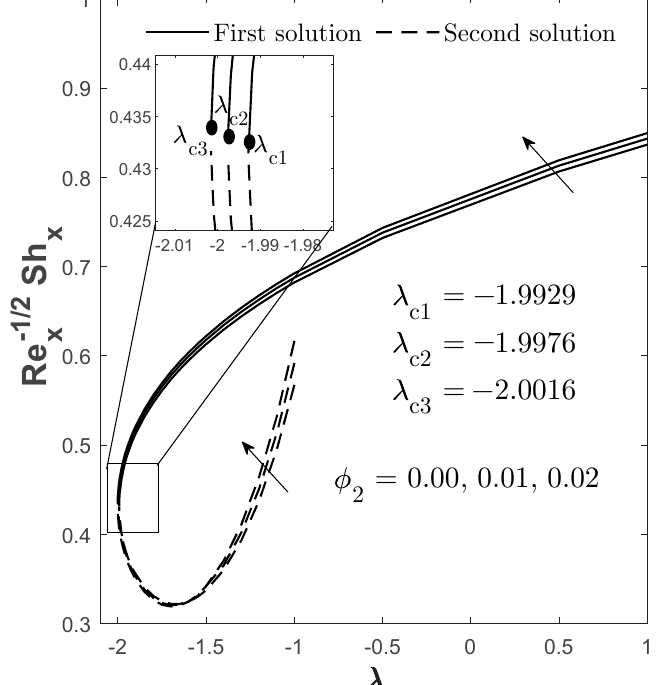
Sh − for varied Figure 4. 1/2 Re x x Figure 4. Re − 1/2 x Sh x for varied φ 2 when N = Rd = Sc = Sr = 1, Du = 0.03, and Bi = 0.1. Figure 4.